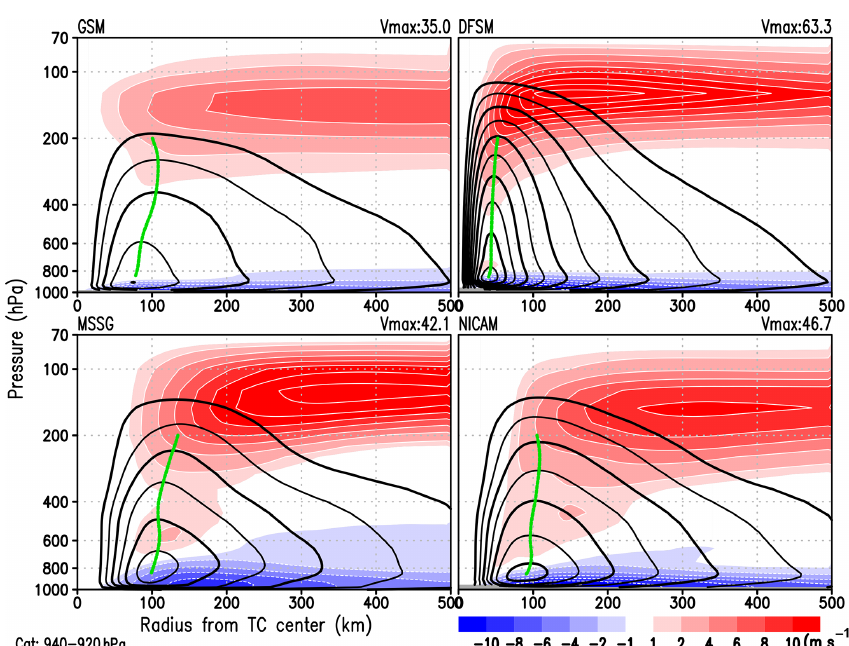
Figure 7. Composite analysis of the radius-height cross section of the axisymmetric mean radial (shaded) and tangential (contour) wind speed for TCs at the time of the analysed central pressure between 920 and 940hPa in the RSMC Tokyo best-track data. Contour intervals are 5ms − 1 (values greater than 15ms − 1 are plotted). The green line depicts the RMW between 850 and 200hPa. The grey shading at the bottom of each panel is below the